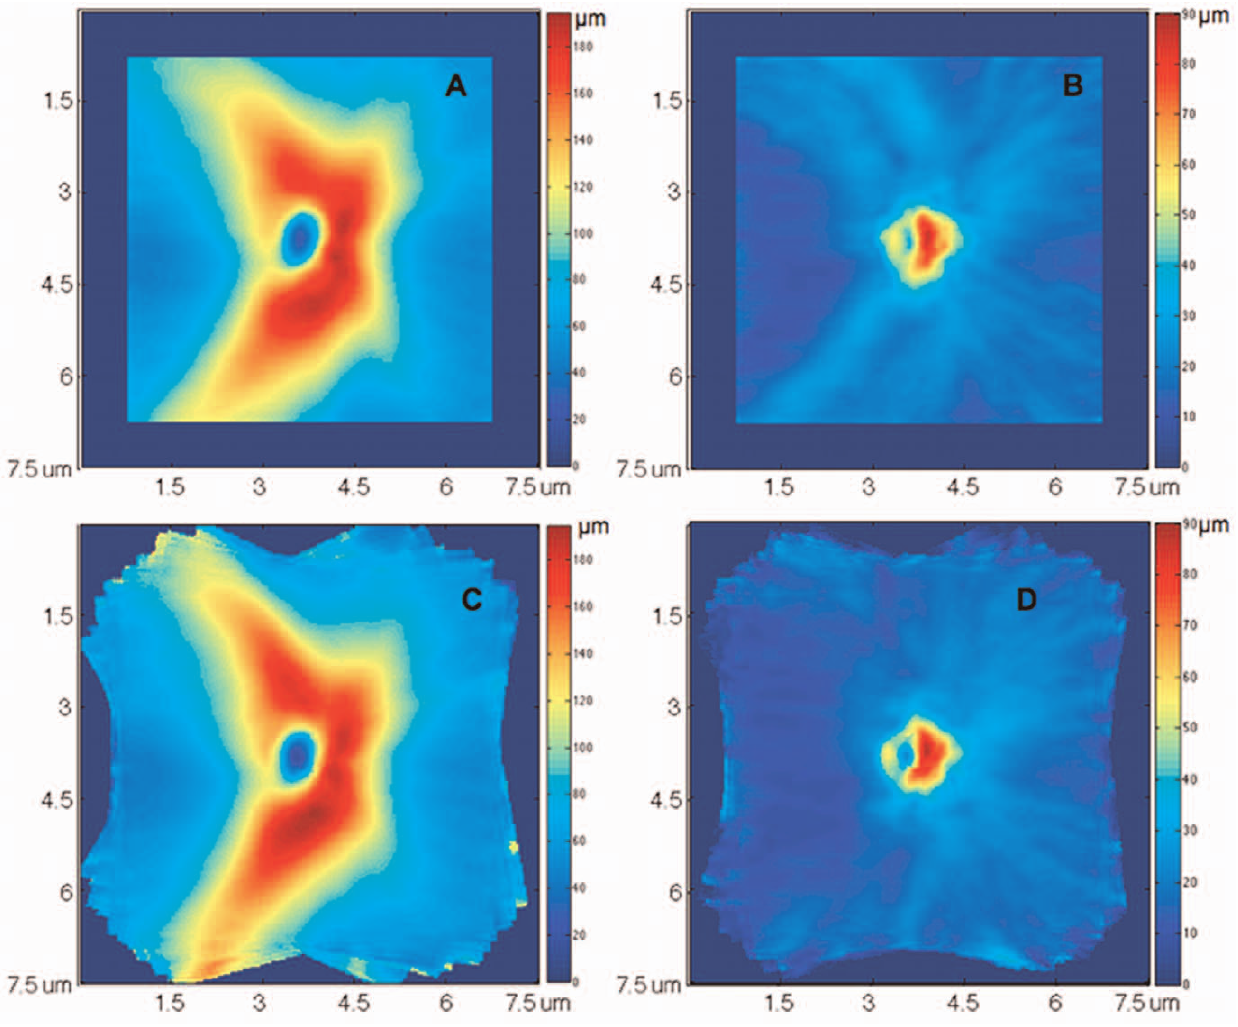
Figure 2. Normative database normalization with 46 healthy eyes. (A, B) mean and standard deviation (SD) of retinal nerve fiber layer (RNFL) thickness measurement at each sampling point (A-scan), without normalization. (C, D) mean and SD of RNFL thickness measurement after normalizing individual’s retinal nerve fiber bundle path location to population’s average location. The variations of RNFL thickness were larger at superior temporal and inferior temporal regions (brighter blue in B) because of the population variation of the bundle locations. After aligning the bundle locations and normalizing the RNFL thickness map, the RNFL thickness variations at these two regions were markedly reduced (dark blue in D).